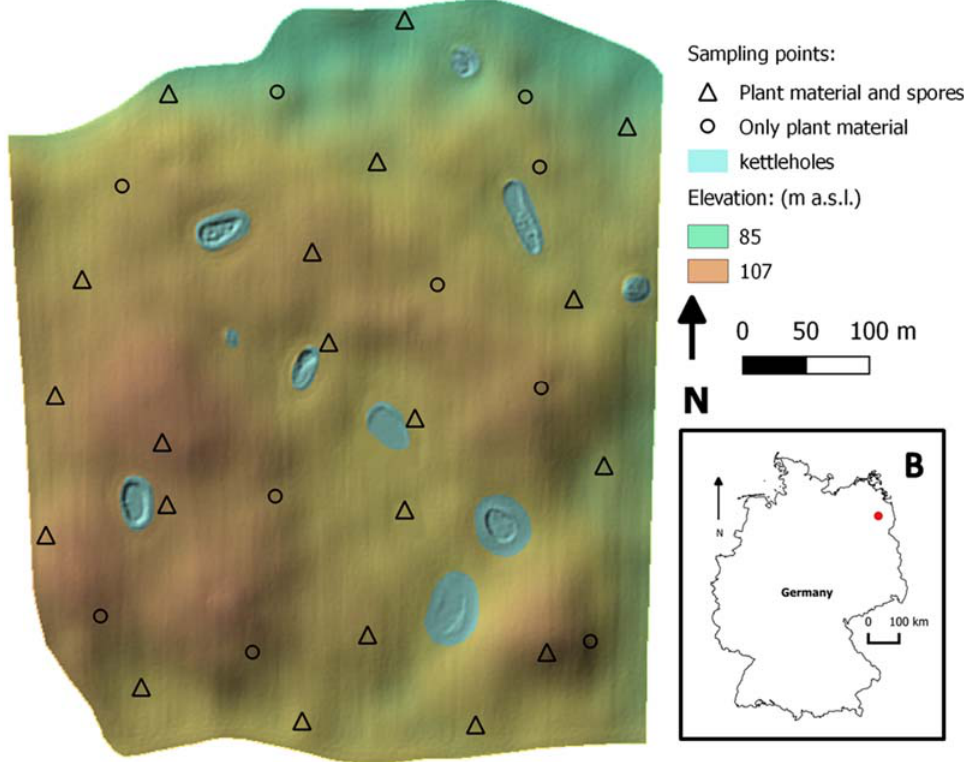
Figure 1. In the main panel, the selected field topography is shown. It is possible to observe its topographic heterogeneity, with hilltops, depressions and small water bodies (kettle holes). With “ ∆ ” the location of sampling points with spore traps is shown, and therefore the fungal presence on both plants and spores was quantified. With “O” the location of sampling points without spore traps installed is shown. In panel B, the location of the study field within the German national borders is shown.